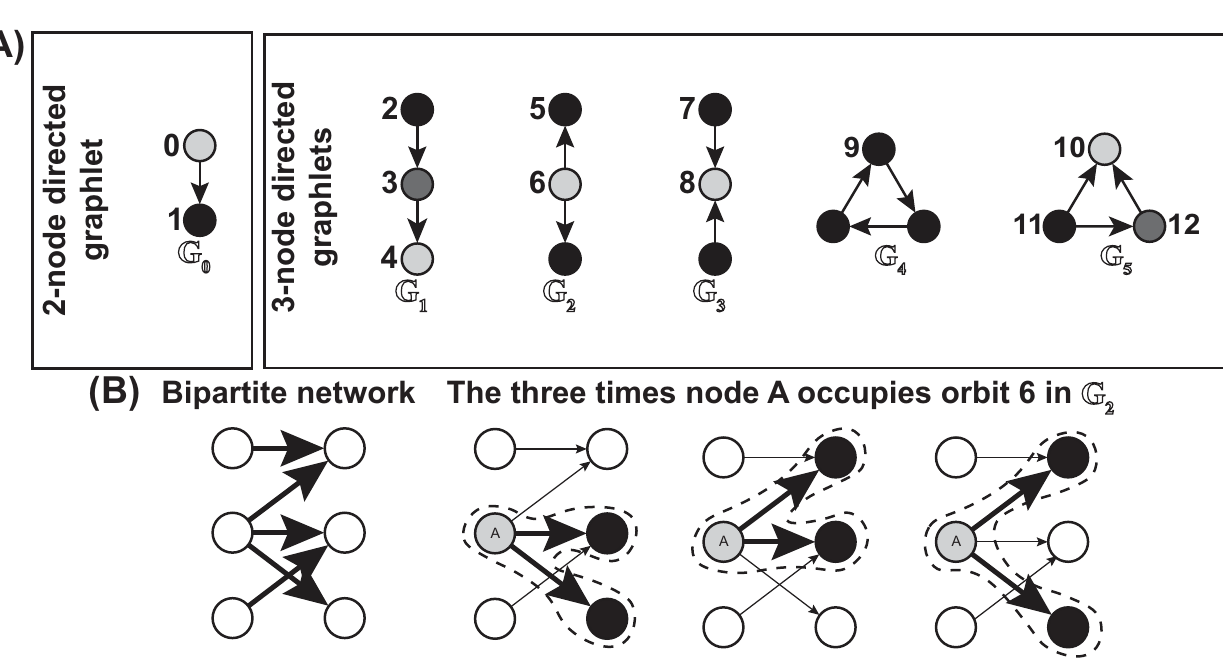
Fig 3. (A) The 6 directed graphlets ( G ) consisting of 2 to 3 nodes and their respective orbits (i.e., the corresponding 13 numerically labeled node positions). i Each unique shade in a single graphlet corresponds to a unique orbit in that graphlet. Note that for the directed bipartite networks used in this study, only graphlets G 0 , G 2 and G 3 appear. (B) An example calculation of the number of times node A of a directed bipartite network occupies orbit 6, where dashed lines indicate the location of G 2